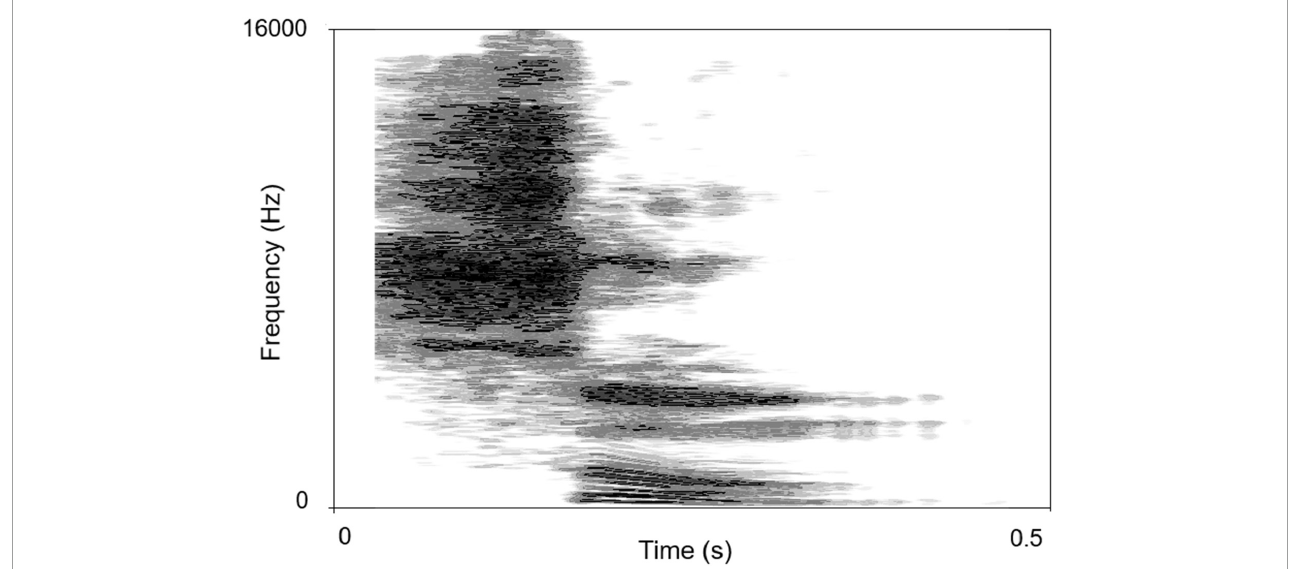
FIGURE3 The spectrogram of “song”. The abscissa is time, the ordinate is frequency, and the gray shade represents intensity.